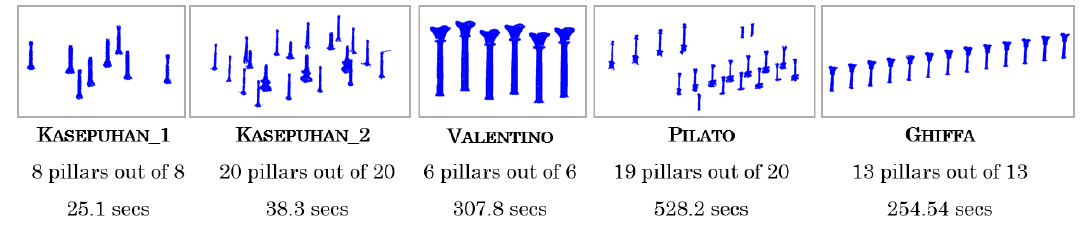
Figure 3. Visual result of the automatic segmentation and labelling for all five datasets.